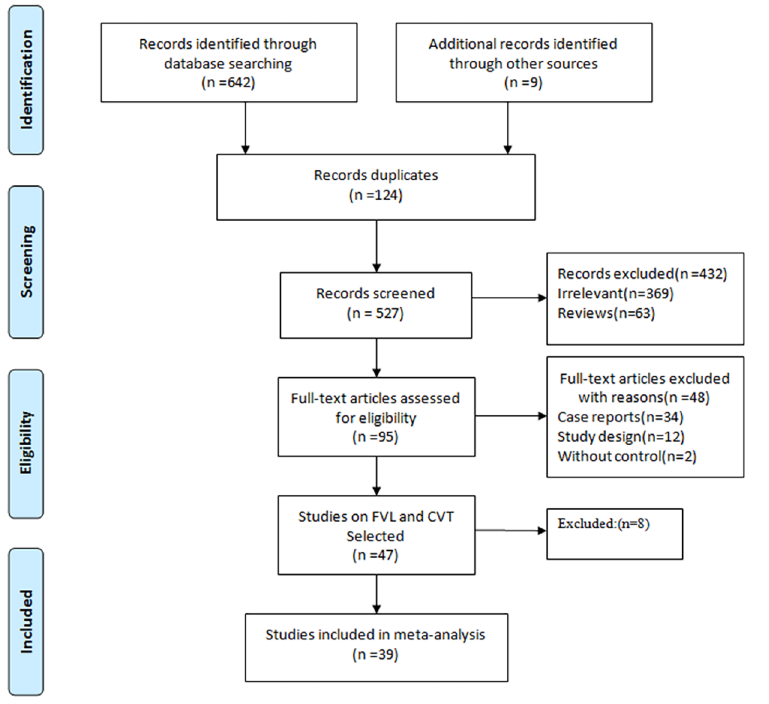
Fig 1. PRISMA flow diagram. FVL, Factor V Leiden; CVT, cerebral venous